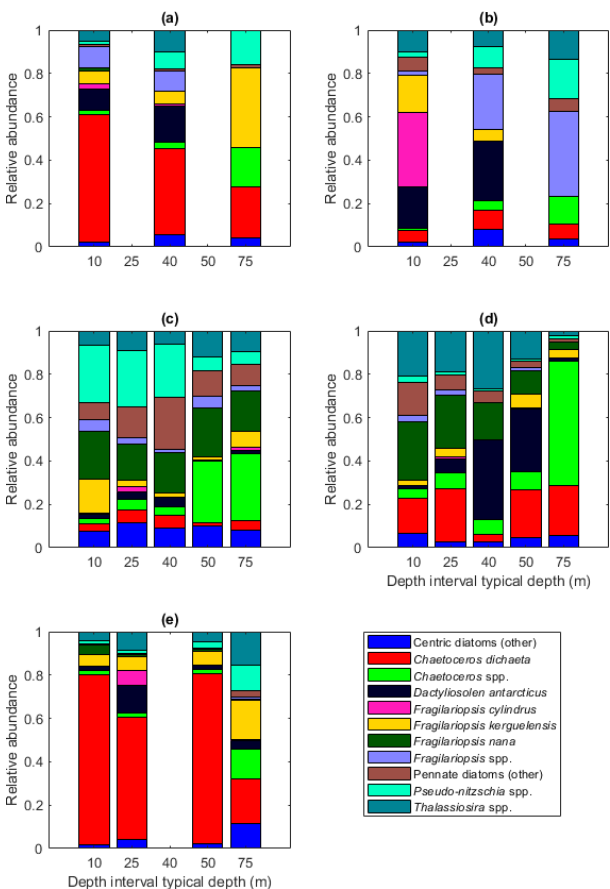
Figure 4. Diatom relative abundance in the different sampling ar- eas averaged per depth interval for (a) station 53, (b) station 54, (c) Astrid Ridge, (d) the 6 ◦ E transect and (e) Maud Rise. Depth in-